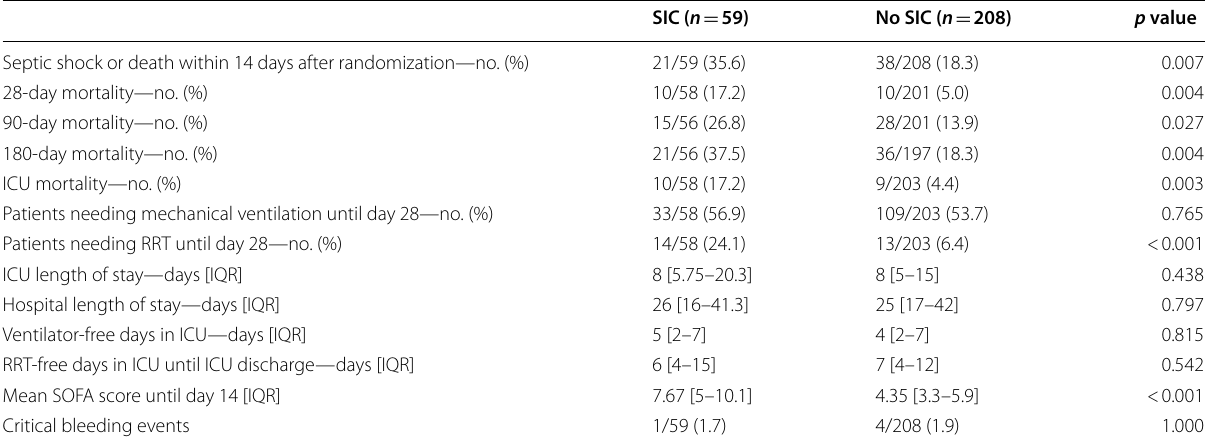
Table 2 Outcome data of the secondary analysis of the HYPRESS trial [14]